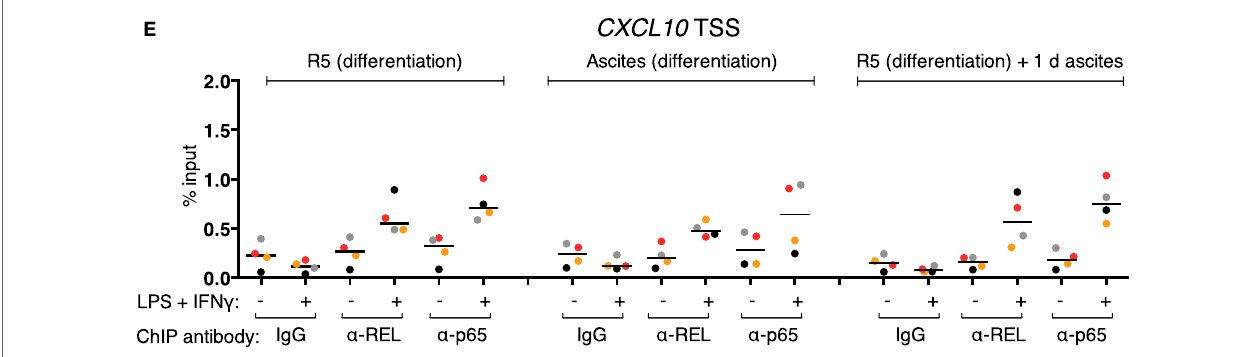
FigUre 5 | Inducible REL and p65 binding at the IL12B and CXCL10 loci in MDMs. (a–e) ChIP-qPCR analyses of REL and p65 binding in chromatin preparations from MDMs differentiated in normal medium, in ascites, or in normal medium followed by ascites for 1 day were conducted. Cells were stimulated with or without LPS and IFN γ ( + ) or their respective solvents ( − ) 2.5 h prior to harvesting. Genomic regions were amplified by specific primers are indicated. The same samples were used as in Figure 4 ( N = 4). Each dot denotes a biological replicate; for each replicate, MDMs from six donors were pooled after harvesting of the cells. Median values are indicated by horizontal bars. Colors encode ascites samples from individual patients, and colors are consistent between panels within this figure, Figure 4 and Figure S9 in Supplementary